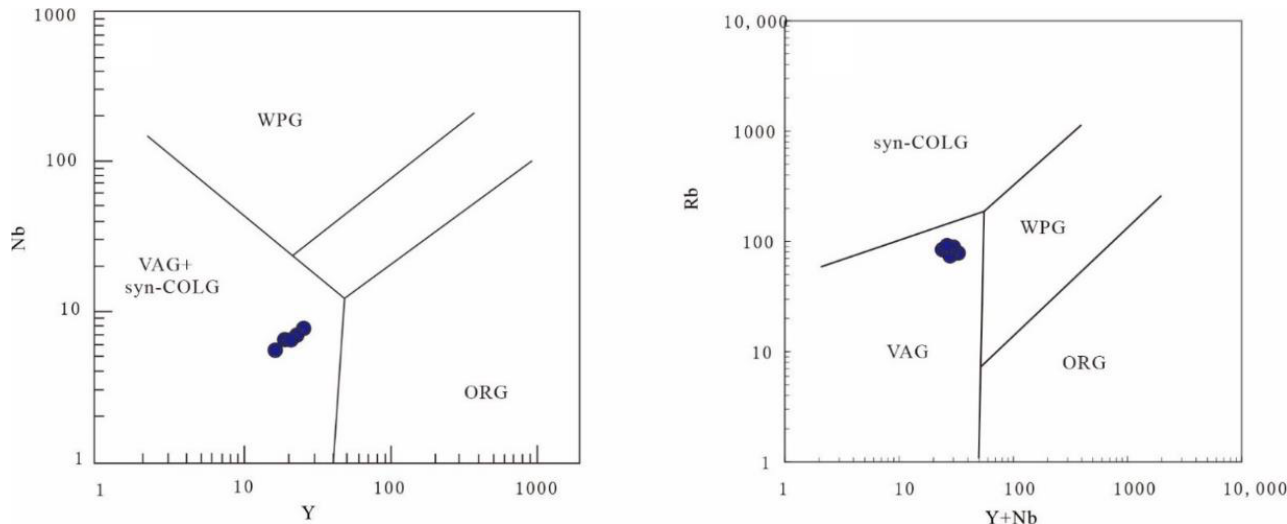
Figure 10. Discriminant diagram of granite dyke tectonic environment in the Jinba deposit (accord- ing to Pearce et al. [70]). WPG — intraplate granite; VAG — volcanic arc granite; Syn-COLG — syn- collisional granite; ORG — ocean ridge granite.